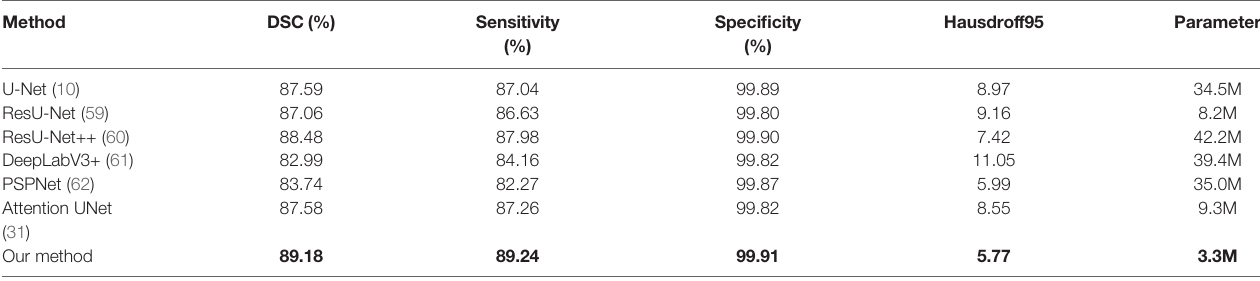
The bold values indicate the best